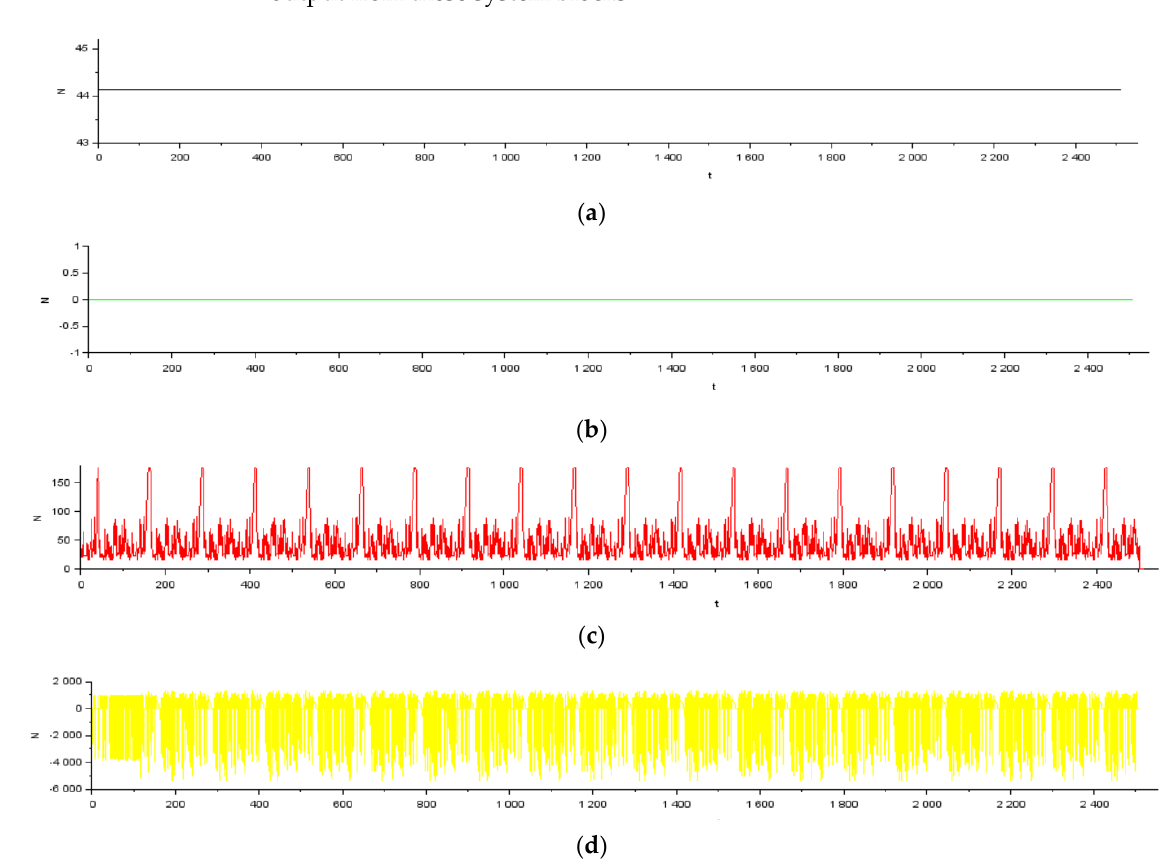
Figure 4. ( a ) Rolling force, ( b ) gradient force, ( c ) aerodynamic force, ( d ) acceleration